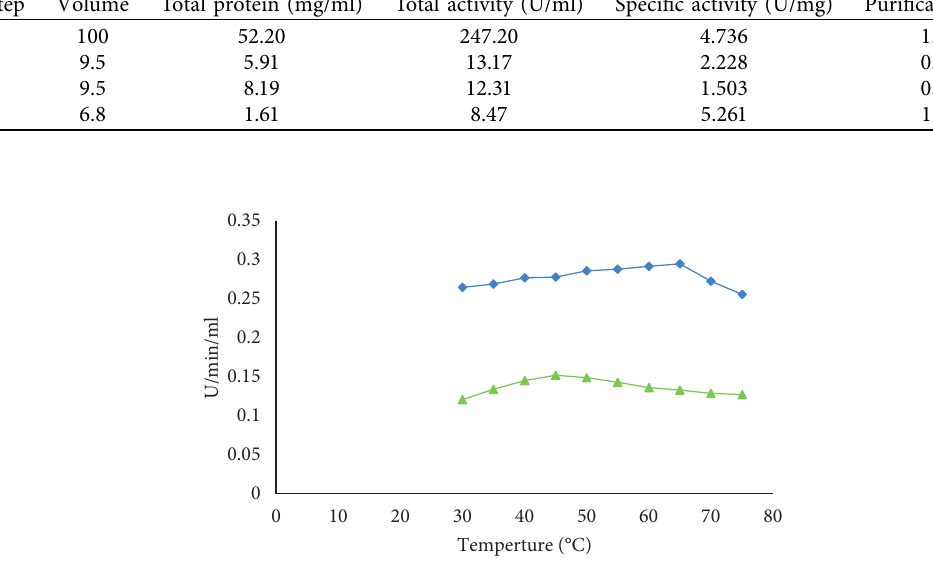
Figure 8: Thermal stability for B. licheniformis (blue) and B. cereus